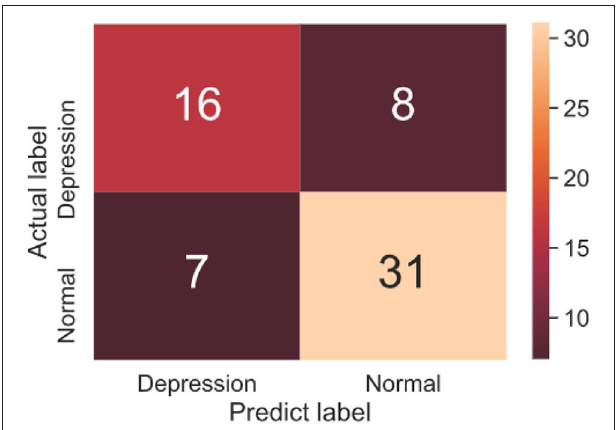
FIGURE 6 | Confusion matrix of binary classification testing set.